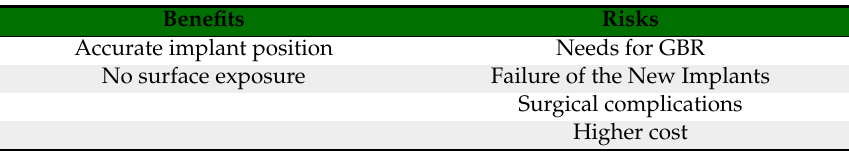
Table 2. Implant removal.